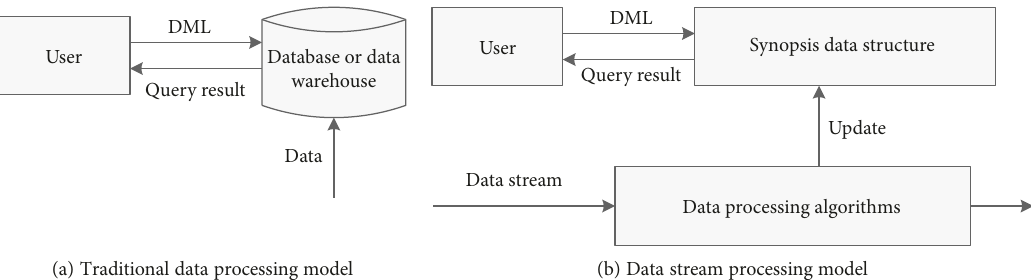
Figure 4: Comparison between the traditional data processing model and the data stream processing